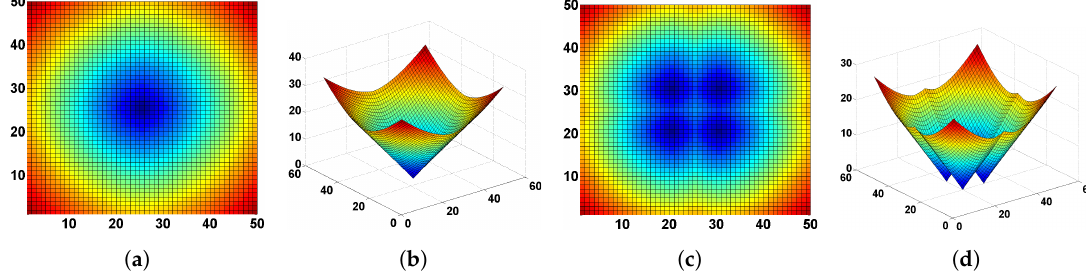
Figure 4. The fast marching method (FMM) applied over a grid map. ( a ) One wave source in two dimensions; ( b ) One wave source in three dimensions; ( c ) Four wave sources in two dimensions; ( d ) Four wave sources in three dimensions.